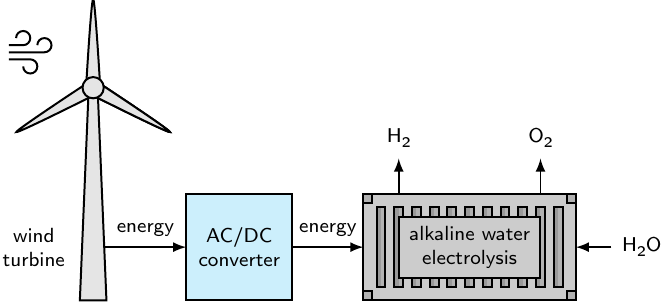
Figure 10. Schematic of alkaline water electrolysis powered by wind energy. Wind turbines convert the available wind power into electricity, which can be used for the operation. The implementation of a suitable AC/DC converter is mandatory